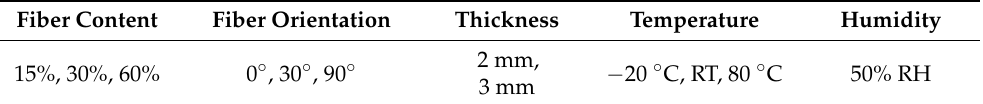
Table 1. Test matrix to produce experimental data for the stress–strain model. Fiber